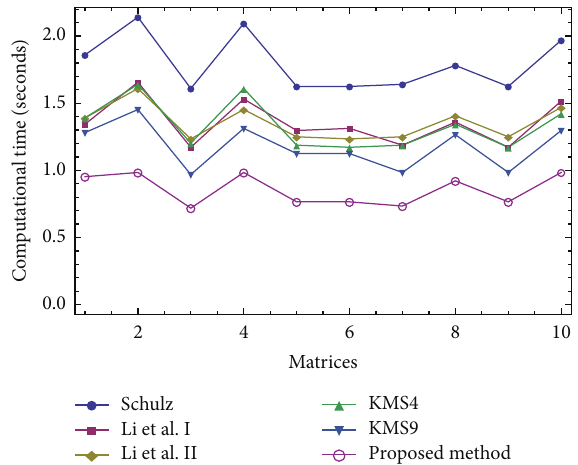
Figure 1: Comparison of the number of evaluations for solving the Test Problem 1 using 𝑉 0 = 𝐴/‖𝐴‖ 2 1 .